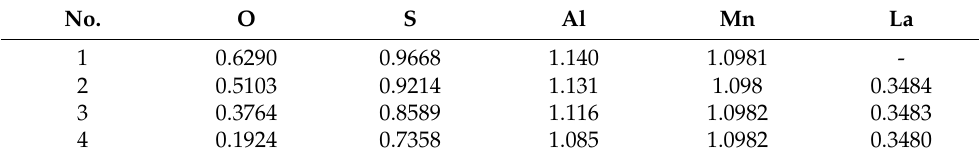
Table 4. The activity coefficients of O, S, Al, Mn, and La in molten steel at 1600 ◦ C. No.